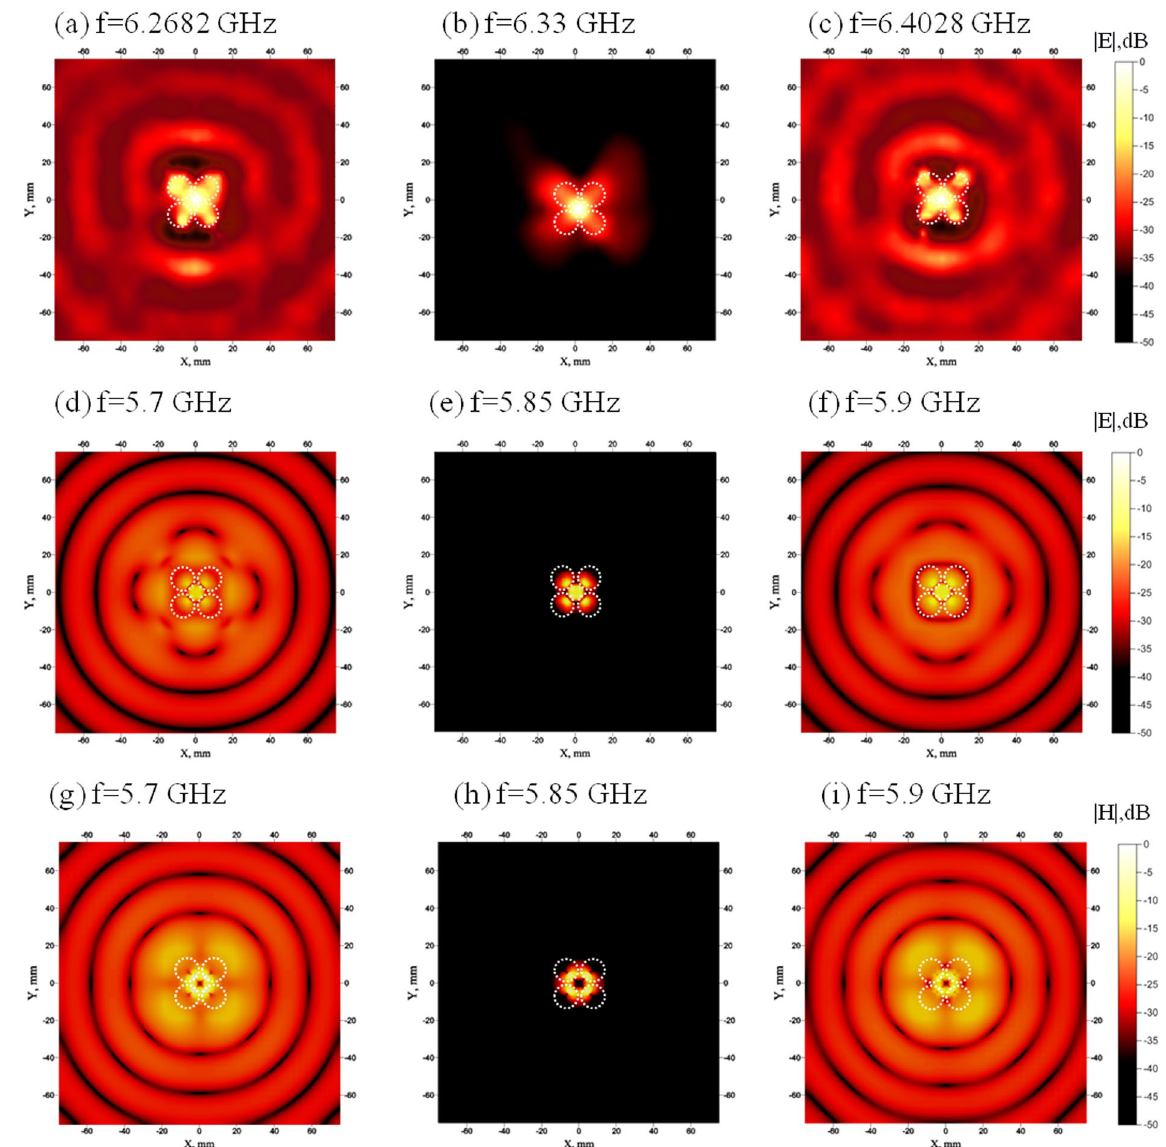
Figure 2. ( a – c ) Measured electric field distributions on the top of the source normalized on maximum field scanned by the 2D probe on the frequencies 6.2682 GHz (toroidal mode), 6.33 GHz (anapole mode) and 6.4028 GHz (toroidal mode), respectively. ( d – f ) Simulated electric field distributions on the top of the source normalized on maximum field on the frequencies 5.7 GHz (toroidal mode), 5.85 GHz (anapole mode), 5.9 GHz (toroidal mode), respectively. ( g – i ) Magnetic field distributions at the same frequencies as ( d – f